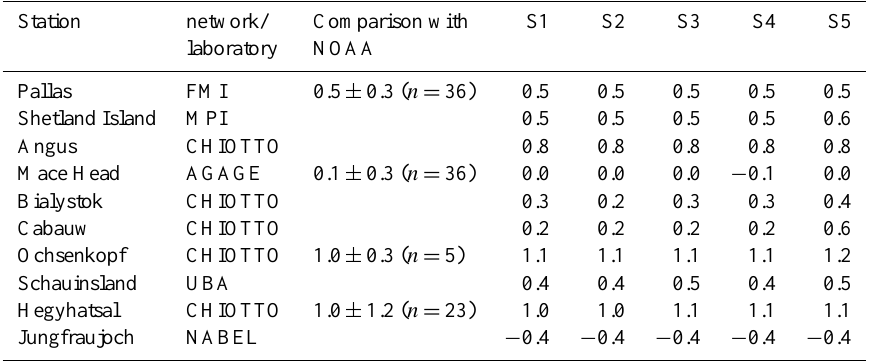
Table 2. Bias corrections for the different European stations. The second column indicates the corresponding network or laboratory. Note however, that all CHIOTTO tall towers (CHI) are treated independently regarding the bias correction. The third column gives the average bias and standard deviation in units of ppb derived from the comparison with the NOAA flask samples which are available at 4 stations (station data minus NOAA data). n represents the number data pairs (measurements coinciding within 1h). The subsequent columns give the bias corrections derived from the different inversions (units are parts per billion - ppb - dry-air mole fraction). Station network/ Comparison with S1